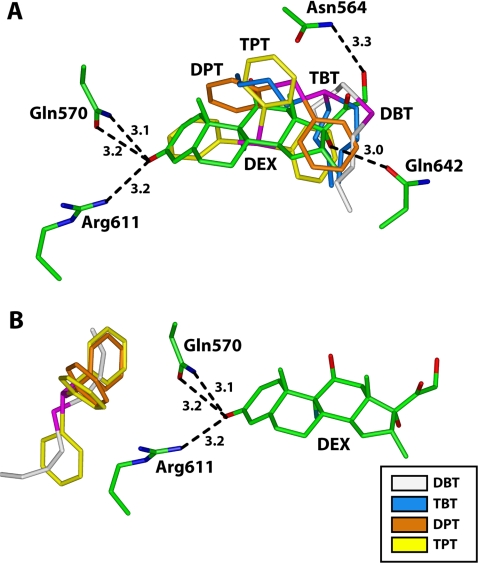
Docking of organotins into the dexamethasone-binding site and at an allosteric site in the GR.
A, DBT (white), TBT (blue), DPT (orange) and TPT (yellow) fit into the dexamethasone-binding site of the GR. In these unminimized complexes with the GR, DBT and TBT overlap the D-ring and DPT and TPT most of dexamethasone. Distances between dexamethasone and Gln570, Arg611, Asn564 and Gln642 are taken from the crystal structure [21]. B, organotins docked into the GR at an allosteric site close to Glu570 and Arg611.